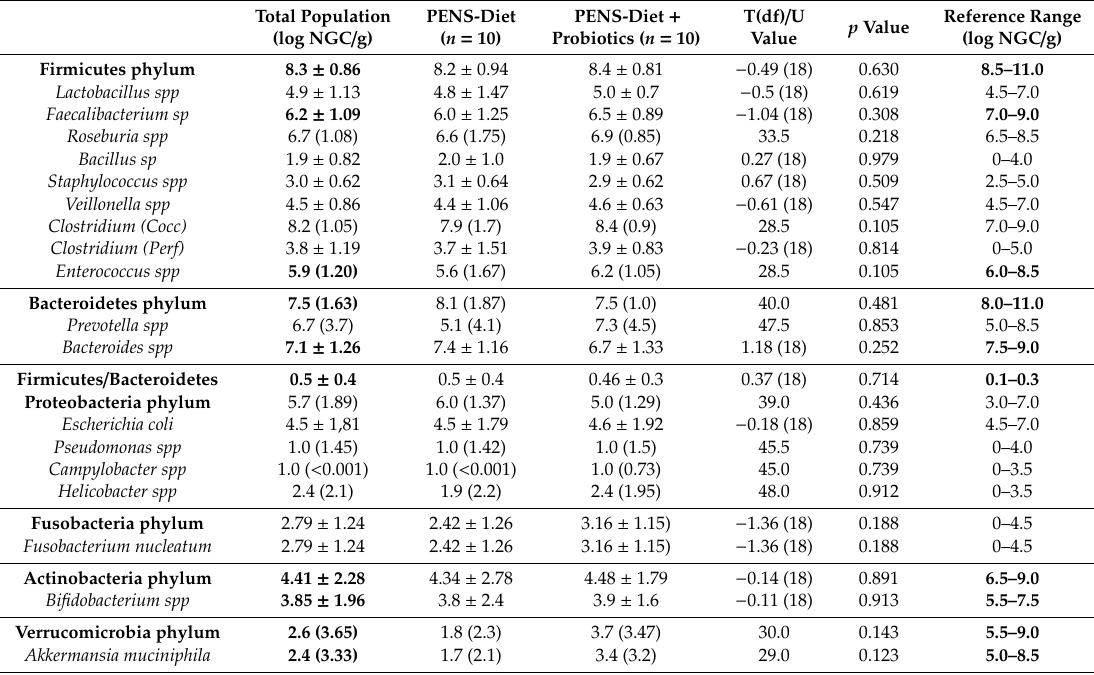
Table 2. Gut microbiota in obese